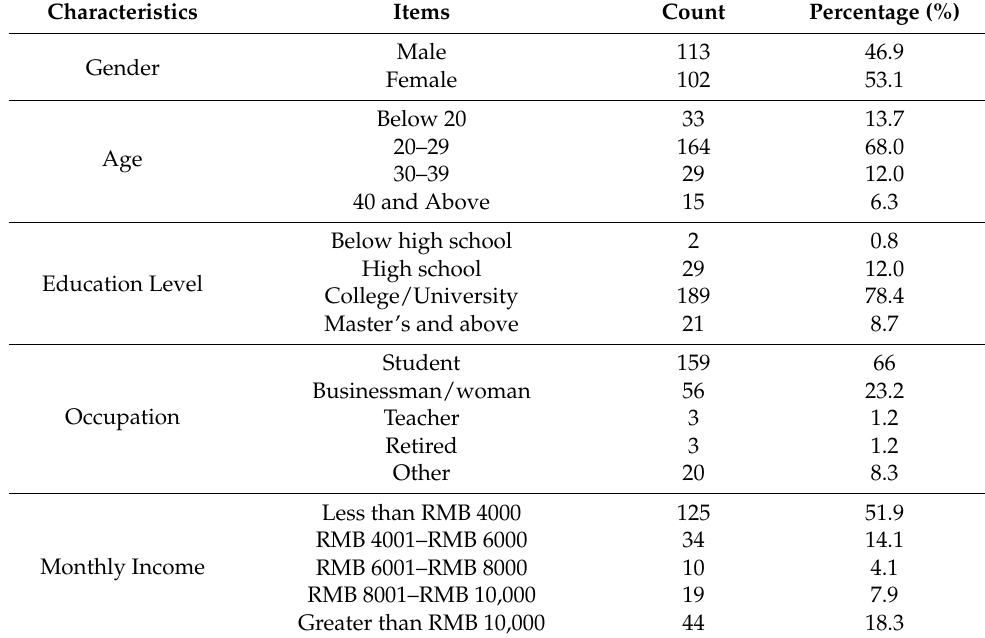
Table A2. Demographic profile of the respondents (N = 241).